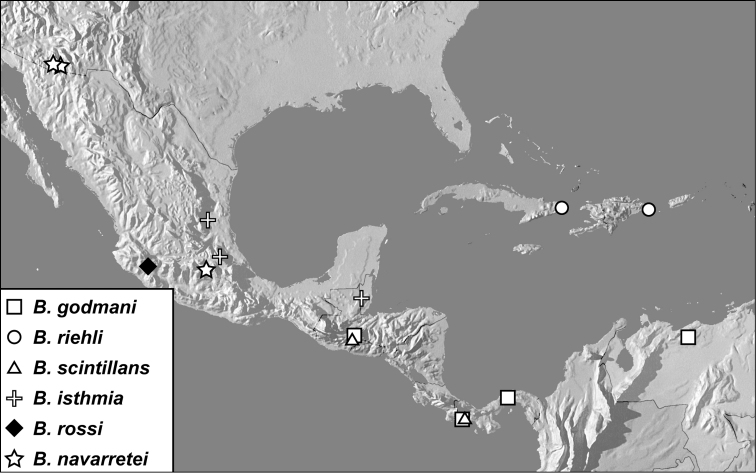
Baconia godmani group records. Record for Baconia godmani in Venezuela is a country record only.